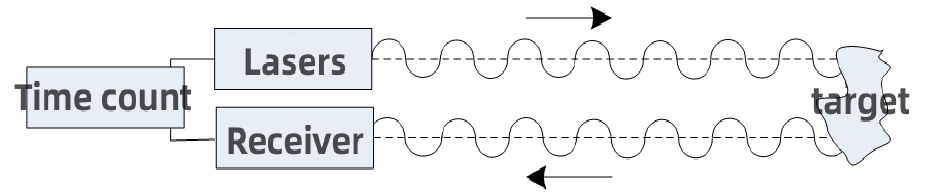
Figure 2. Schematic diagram of pulse ranging.